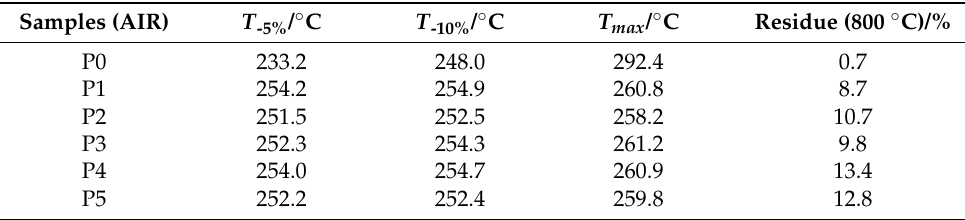
Table 5. Thermogravimetric data of FR-POM composites in AIR atmosphere.